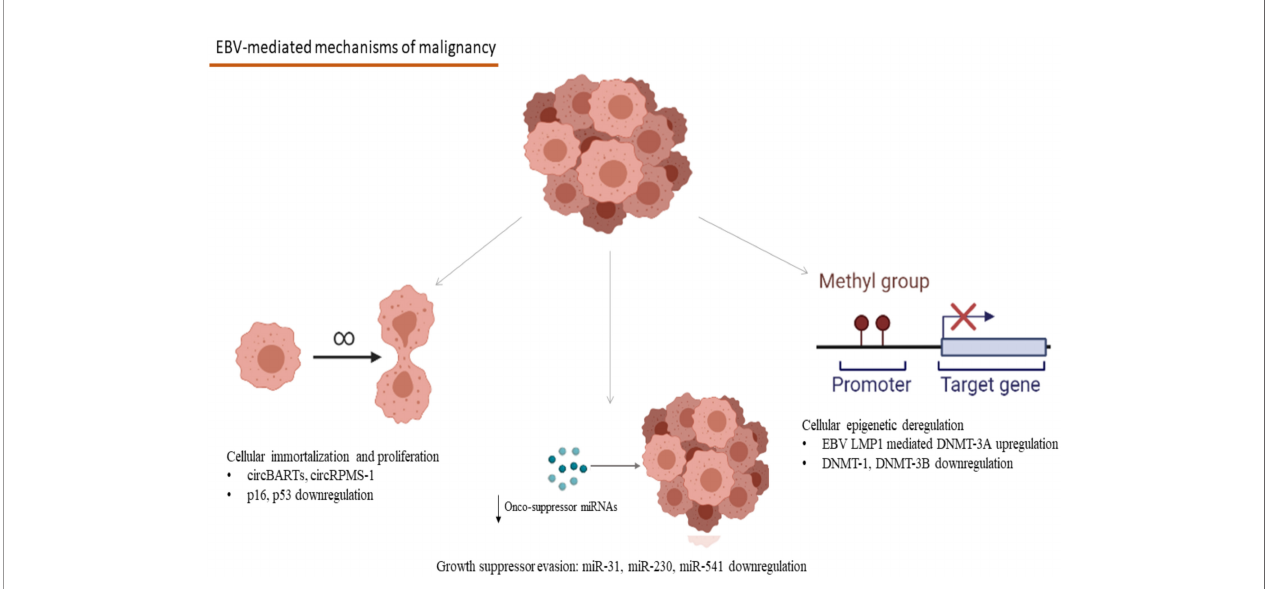
FIGURE 1 | Mechanisms involved in the EBV-associated carcinogenesis: CircBARTs and circRPMS1 are implicated in the cellular immortalization and the induction of uncontrolled proliferation. CircRPMS1 is negatively correlated to the expression of innate oncosuppressor miRNAs (miR-31, miR-230 and miR-541), as observed in NPC. Gene expression modi fi cation takes place in B-cell malignancies, as a result of the methylation pattern-modi fi cations caused by the EBV infection through the EBV LMP1 mediated upregulation of DNMT-3A and the downregulation of DNMT-1 and DNMT-3B (EBV, Epstein – Barr Virus; circBARTs, circular BamHI A rightward transcripts; miRNAs, microRNAs; NPC, Nasopharyngeal Carcinoma; EBV LMP1, EBV latent membrane protein 1; DNMT, DNA methyltranserase). Created in